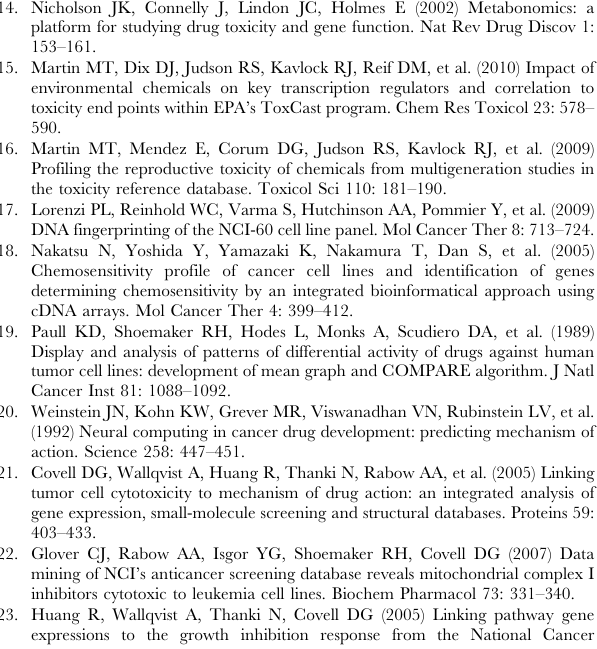
Table S1 U133A-derived genes selected to discriminate sensitive versus insensitive tumor cell responses to CPT. Genes are ordered from top to bottom according to correlation strength. Top 16 genes represent discriminating genes with expressions negatively correlated to CPT’s SOM NCI60 GI50 profile, where over expression corresponds to chemo-insensitivity. The bottom 38 discriminating genes have expressions positively correlated to CPT’s SOM NCI60 GI50 profile, with over expression corresponding to CPT chemo-sensitivity. Proteasomal genes are highlighted in bold. Table S2 GSEA Results for Supplemental Test Com- pounds. (DOC) Text S1 The Supplementary Test Compounds section in Text S1 and Table S2, includes results for an additional 18 test compounds, the GSEA pathways identified by their discriminating gene and supporting literature validations. In principal, each SOM node can yield a set of discriminating genes that can be associated with its cluster members. Selecting an appropriate SOM node will depend, in part, on special interest in a set of compounds or a set of discriminating